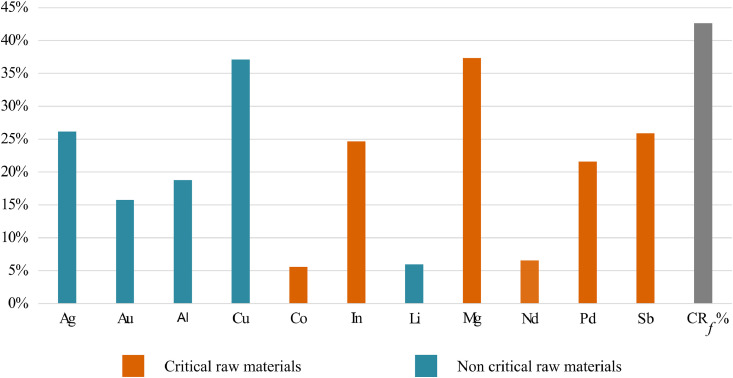
WEEE category II in France: collection rate per target element (2017).